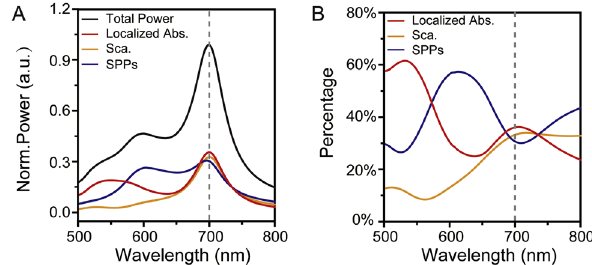
Figure 4: (A) Simulated intensity of each energy component during the plasmon dissipation. The black line represents the total energy losses, including the energy loss from localized absorption (red line), far-field scattering (orange line), and the SPPs excitation (blue line). (B) The percentage of the three energy components. The gray dashed lines in two figures indicate the resonant wavelength of the LSPR (700